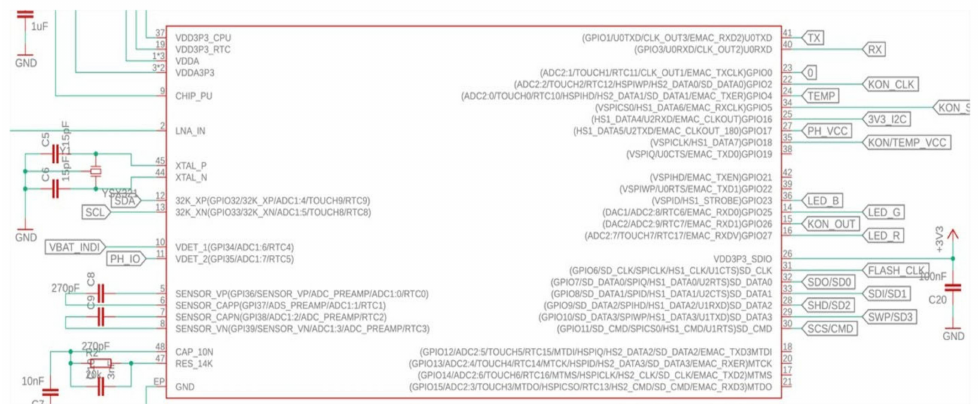
Figure 4. The part of the scheme of an electrical schematic